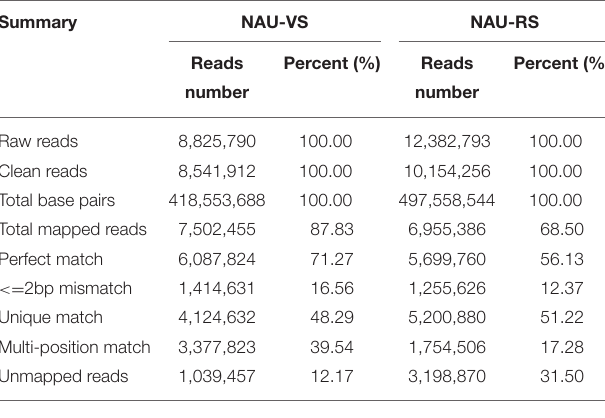
TABLE 1 | Summary of DGE sequencing and mapped reads.